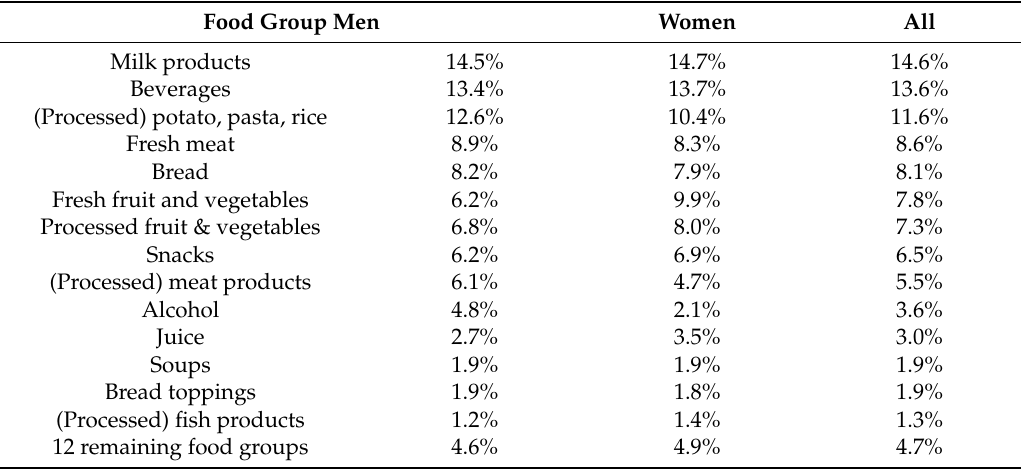
Table 2. Food groups contributing to potassium intake at baseline, split by